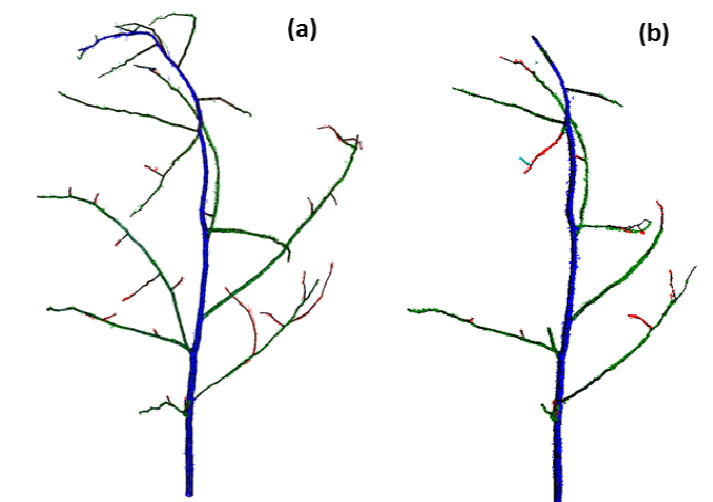
Figure 3. Quantitative structure models of the aspen branch (with cylinders plotted over the point cloud): ( a ) the original branch; ( b ) the branch after the third cut. The order of branches has been denoted with colours: the stem (the main branch) is blue, the first order and second order branches are green and red,